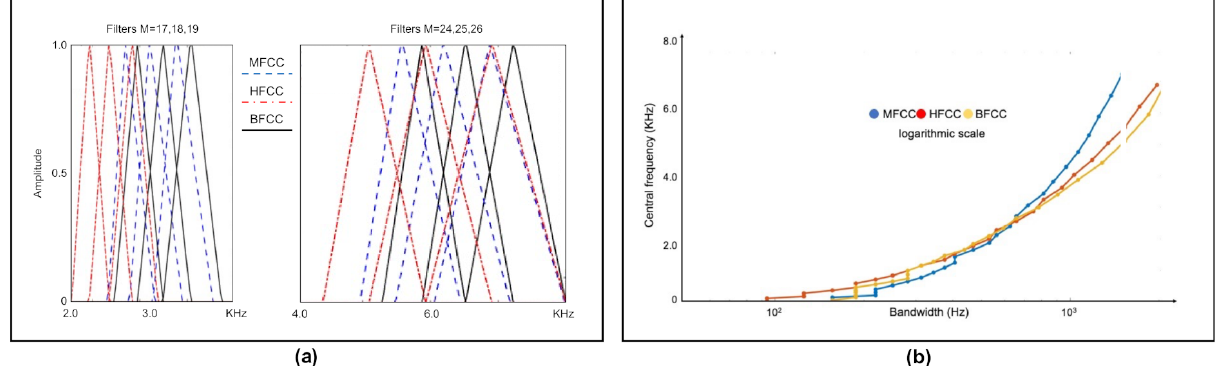
Figure 3. ( a ) Representation of 6 filters corresponding to each bank, with lower M corresponding to filters with lower central frequency. At lower frequencies, the Bark and HFCC filters have a lower bandwidth; this bandwidth increases in relation to the filter’s central frequency, which is higher for higher frequencies. The bandwidth of the MFCC corresponds to [ fc m − 1 , fc m + 1 ] . The center frequencies of the filters correspond to those of Table 1. ( b ) Relation between bandwidth and central frequency of the filters in a logarithmic scale. Points correspond to filter M =